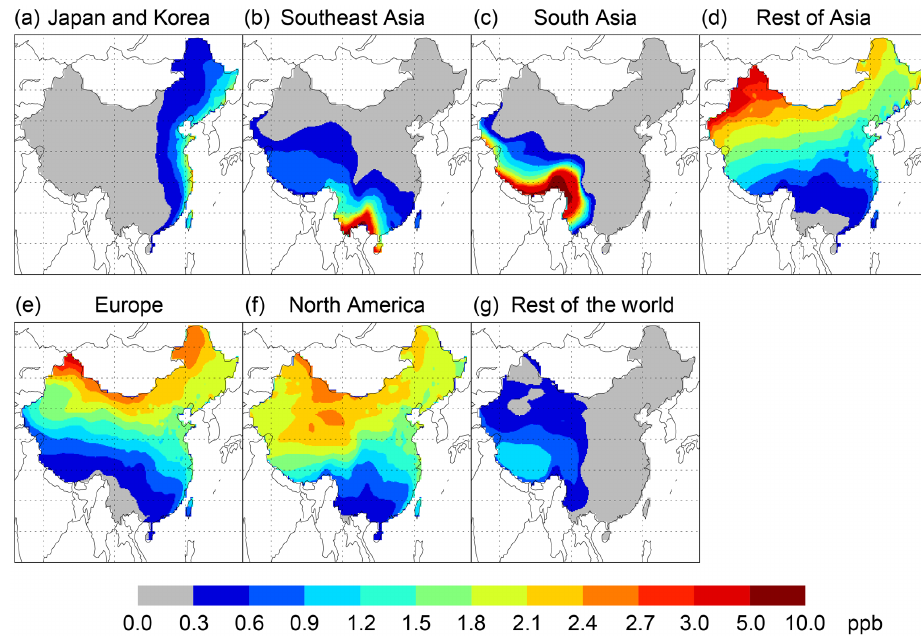
Figure 10. Spatial distribution of springtime daily mean surface ozone over China contributed by anthropogenic emissions of individual regions. The ozone enhancement over China by anthropogenic emissions of each region is determined by the difference between the base case simulation CTL and zero-out simulation without that region’s anthropogenic emissions, followed by the linear weighting adjustment.